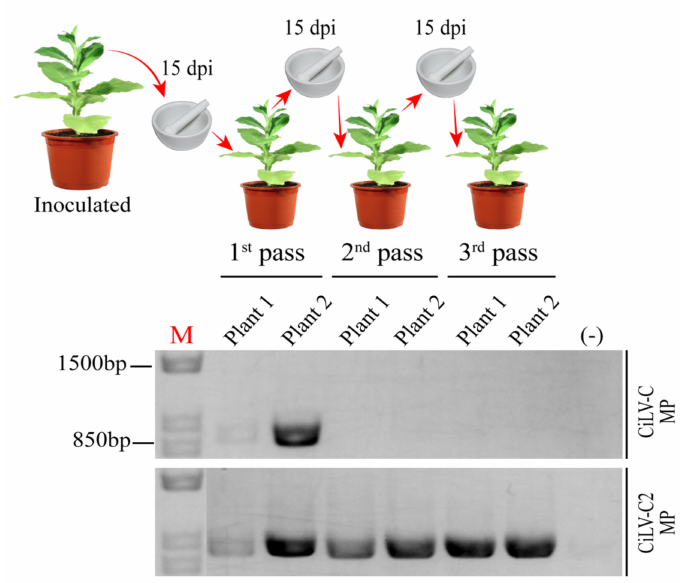
Figure 2. Competition analysis between alfalfa mosaic virus constructs expressing the MPs of CiLV-C and CiLV-C2 in transgenic N. tabacum plants. Co-inoculation of N. tabacum P12 plants with an infectious mixture containing equivalent amounts of AMV RNA 3 derivatives transcripts carrying the MP genes of the CiLV-C and CiLV-C2. These AMV RNA 3 derivative constructs are the same as shown in Figure 1A (pMP-CiLV-C WT :A44/CP and pMP-CiLV-C2 WT :A44/CP). Schematic representation of three serial passages at 15 day intervals using extracts of the systemic leaves as inoculum is presented. The prevalent virus for each passage was determined by RT-PCR analysis using specific primers for each MP gene. The presence or absence of the correspondent MP DNA band in agarose gel electrophoresis is shown through RT-PCR analysis of two plants for each viral passage. The assay was repeated three times. (-) corresponds to a healthy plant. M = GeneRuler 1 kb DNA ladder marker. The marker band sizes of 1.5 kbp and 850 bp are